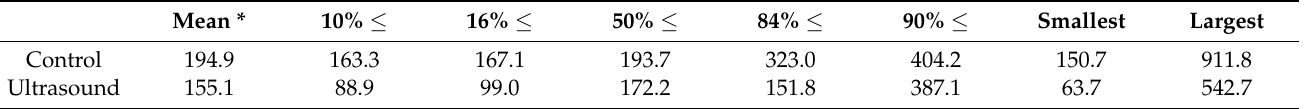
Table 4. Particle size of chicken feathers, control, and treated samples with